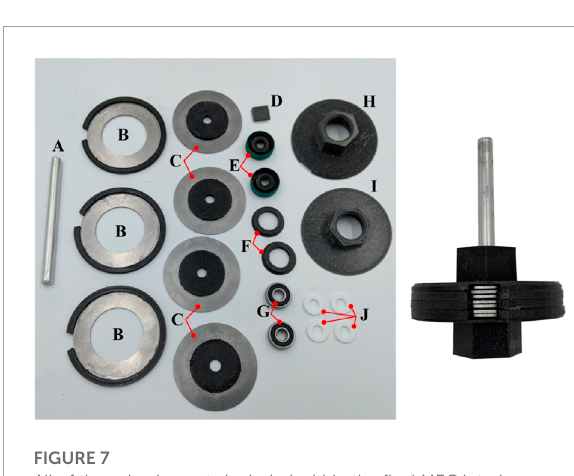
FIGURE 7 All of the sub-elements included within the final MEC